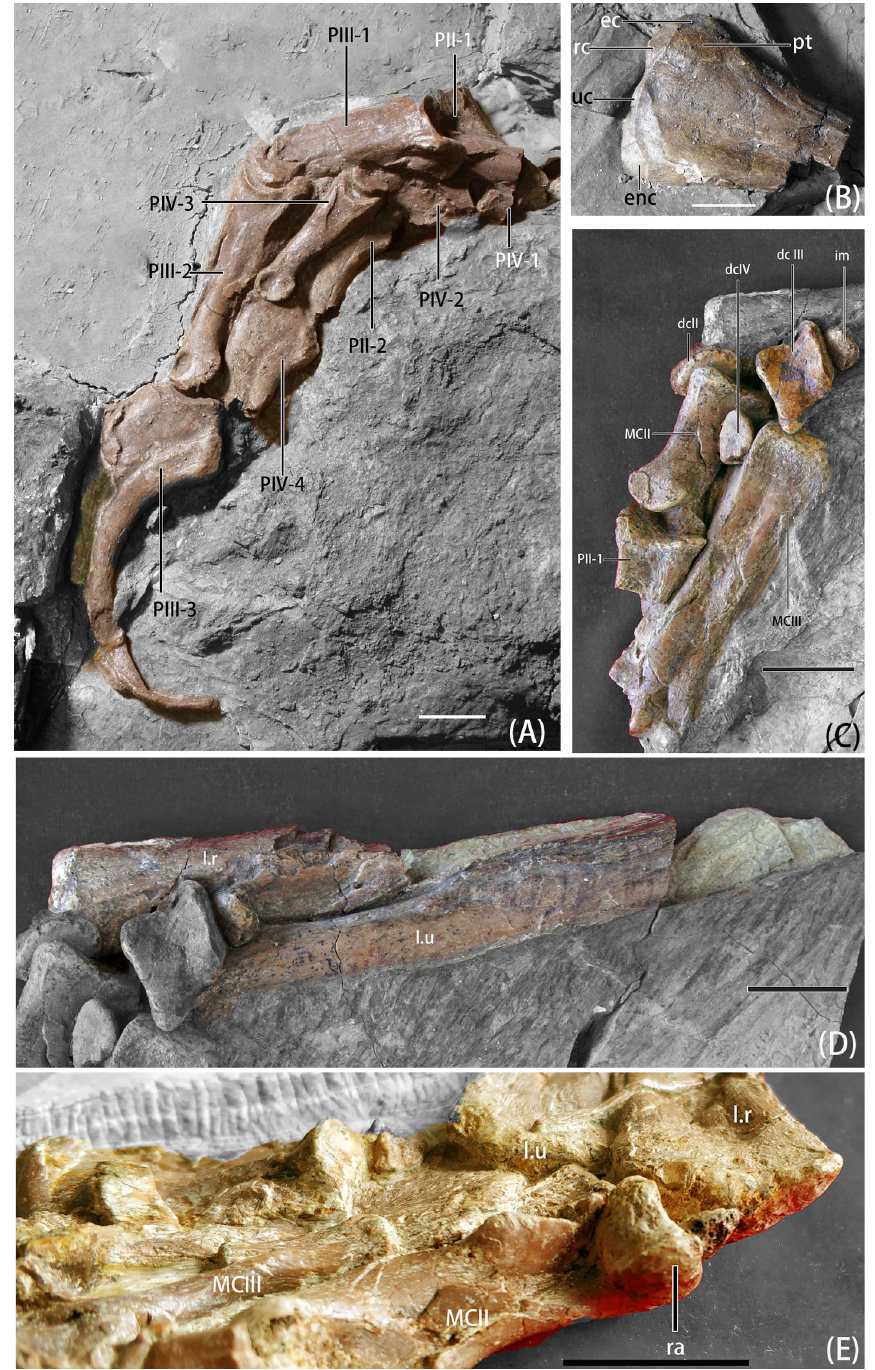
Fig 7. Photographs of left forelimb elements of B . inexpectus (IVPP V 11559) A. manus elements in lateral view; B. humerus distal end in posterior view; C. carpus and metacarpus; D. radius and ulna; E. manus elements in anterior view. Abbreviations: ec , ectepicondyle; dcII-IV , distal carpal II-IV; enc , entepicondyle; l.r , left radius; l.u , left ulna; im, intermedium; MCII-III , metacarpus II-III ; PII-1 to PIV-4 , phalanges II-1 to IV-4; pt , posterior tuberosity; ra , radiale; rc , radial condyles; uc , ulnar condyles. Scale bars equal 2